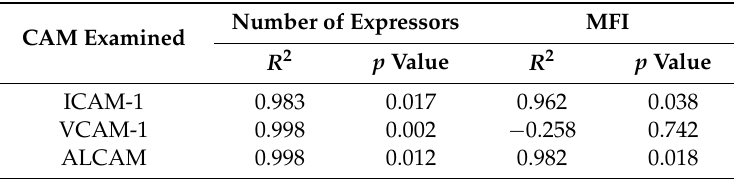
Table 1. CAM (cellular adhesion molecule) surface expression correlates with CD3 + cell adhesion. Linear regression analysis based on results from three independent experiments performed in triplicate for both the cell adhesion assay and staining for CAM surface expression. Number of Expressors MFI CAM Examined R 2 p Value R 2 p Value ICAM-1 0.983 0.017 0.962 0.038 VCAM-1 0.998 0.002 ´ 0.258 0.742 0.998